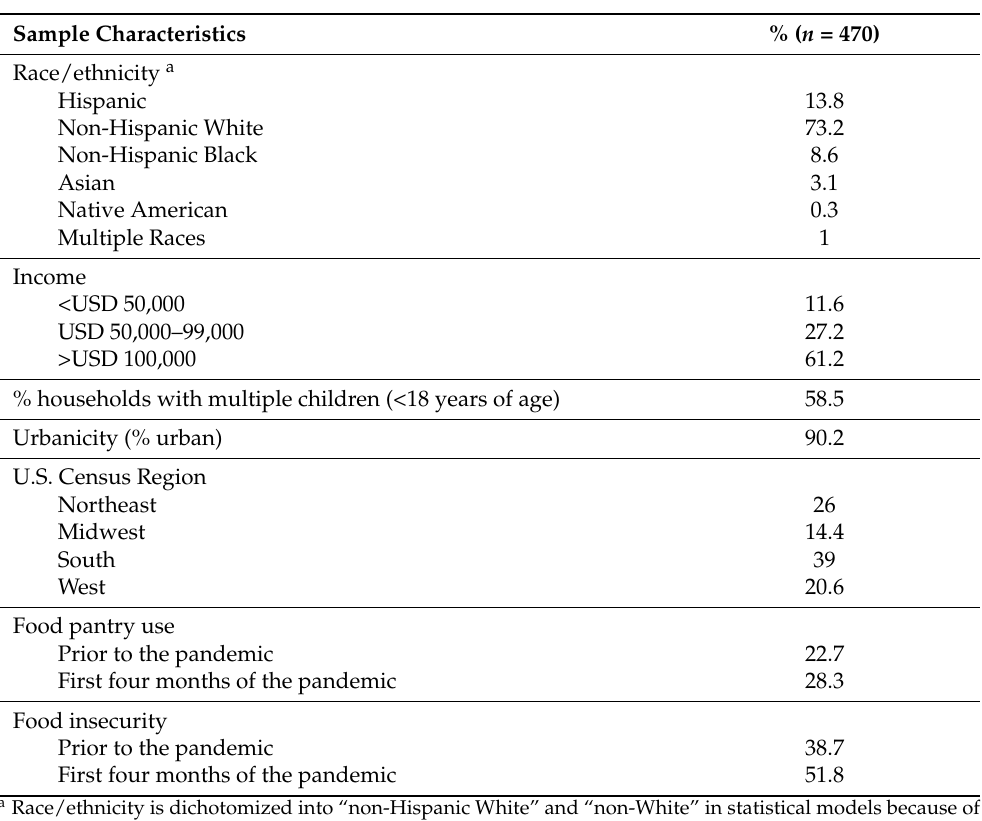
Table 1. Demographic characteristics of households with children prior to and during the first four months of the pandemic ( n = 470).